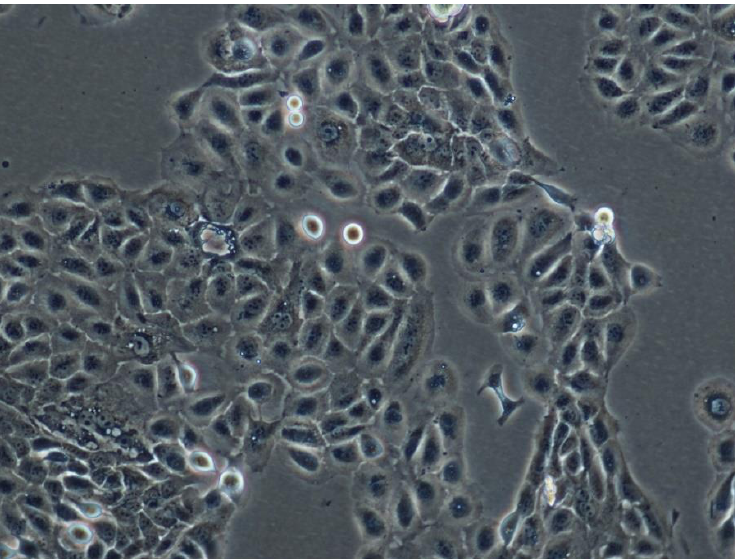
Figure 6. Phase-contrast micrograph of HaCaT keratinocytes in culture flask (original magnification: ×100).